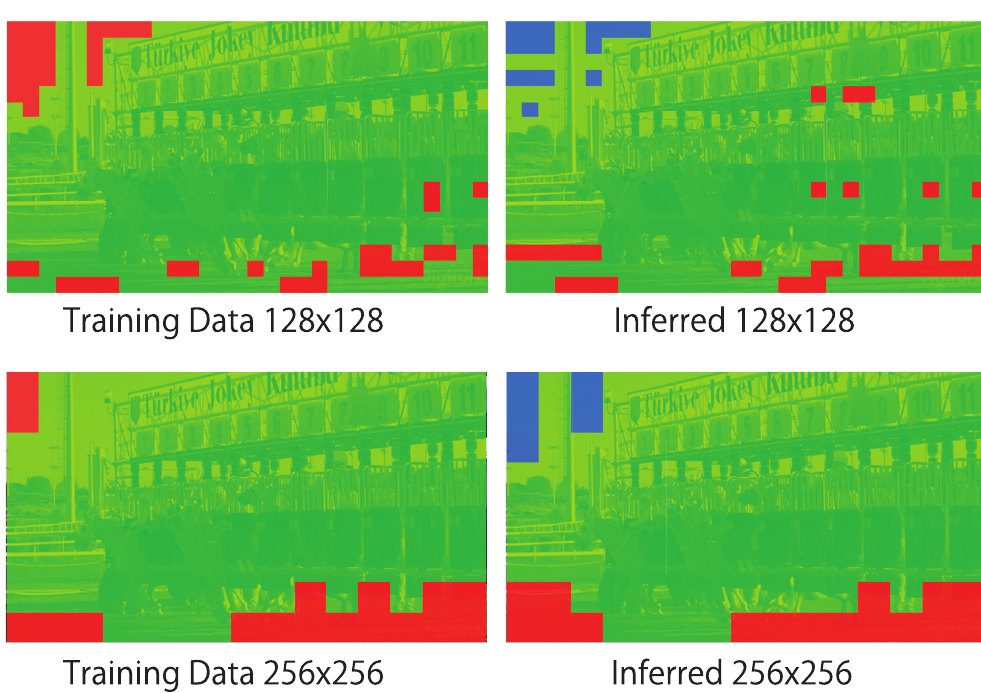
Figure 11. Comparisons among distributions of compression programs used for training and inferred by DNN